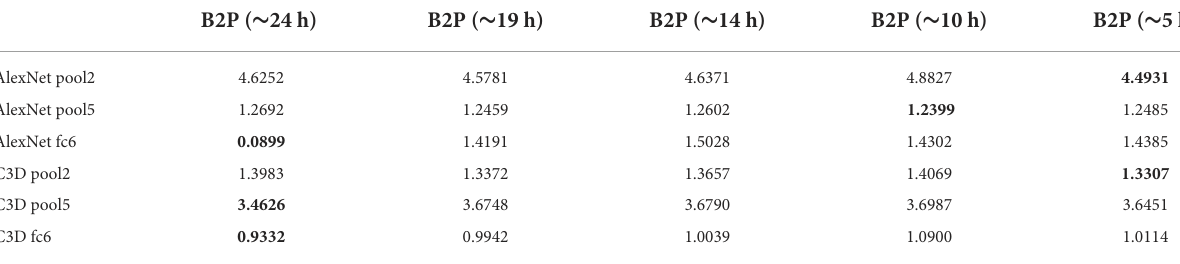
TABLE 8 Splitted data distance values: the model was trained on data worth of 5, 10, 14, 19, and 24